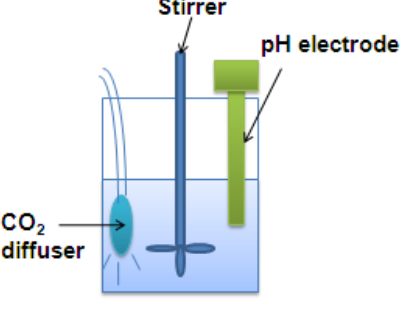
Figure 18. Apparatus of accelerated carbonation at a wet condition (modified from Todorovic et al .